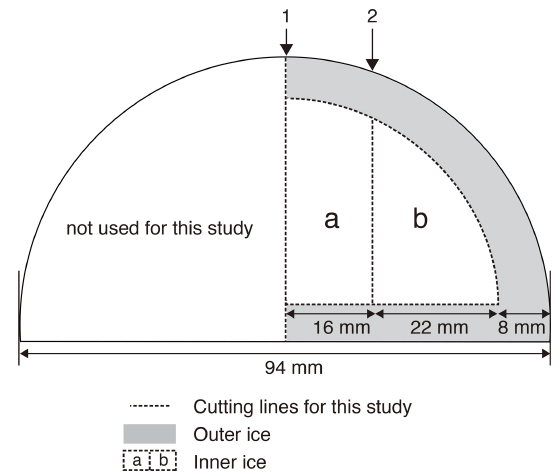
Figure 12. Typical cross-sectional cutting plan of the DF core for duplicate measurements and outer–inner comparisons for mass spectrometer analyses. The sample length is ∼ 12cm. The original outer surface (black line) has been exposed to the atmosphere for ∼ 20 years. The ice is first cut at line 1, then the outer part is re- moved, and finally the inner ice is cut at line 2 into “a” and “b” pieces. Dashed lines indicate the boundaries between “a,” “b,” and “outer” pieces. For a single (non-duplicate) measurement, the ice is not cut at line 1 (only cut at line 2 to produce the “b”